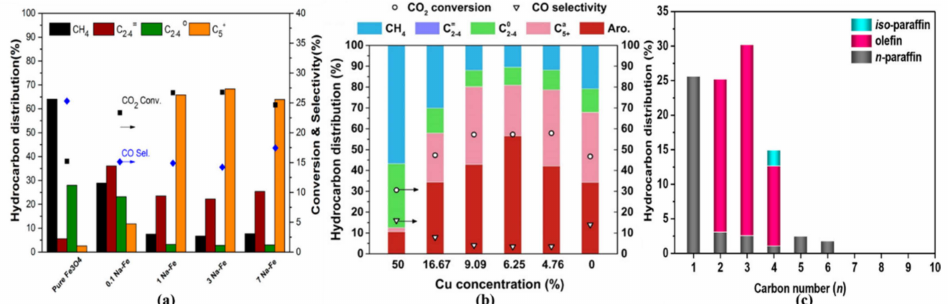
Figure 11. ( a ) Catalytic performance of Na-Fe 3 O 4 catalysts with different Na contents. Reaction con- ditions: 320 ◦ C, 3.0 MPa, GHSV = 4000 mL · g cat − 1 · h − 1 , TOS = 48 h. Reprinted with permission from Wen et al. [111]. Copyright (2020) American Chemical Society. ( b ) Hydrocarbon distribution, CO 2 conver- sion, and CO selectivity over nCu-Fe 2 O 3 /HZSM-5-c catalysts with various Cu concentrations. HZSM-5-c represents commercial HZSM-5. Reaction conditions: 320 ◦ C, 3.0 MPa, GHSV = 1000 mL · g cat − 1 · h − 1 , H 2 /CO 2 /N 2 = 72/24/4, 2 g tandem catalysts. Reprinted with permission from Song et al. [115]. Copy- right (2020) American Chemical Society. ( c ) Product distribution over the sole FeK1.5/HSG catalysts. Reaction conditions: 340 ◦ C, 2.0 MPa, GHSV = 26,000 mL · g cat − 1 · h − 1 (relative to the total catalyst weight), H 2 /CO 2 = 3, 150 mg of FeK1.5/HSG, 150 mg of HZSM-5(50), TOS = 24 h. Reprinted with permission from Wang et al. [112]. Copyright (2019) American Chemical